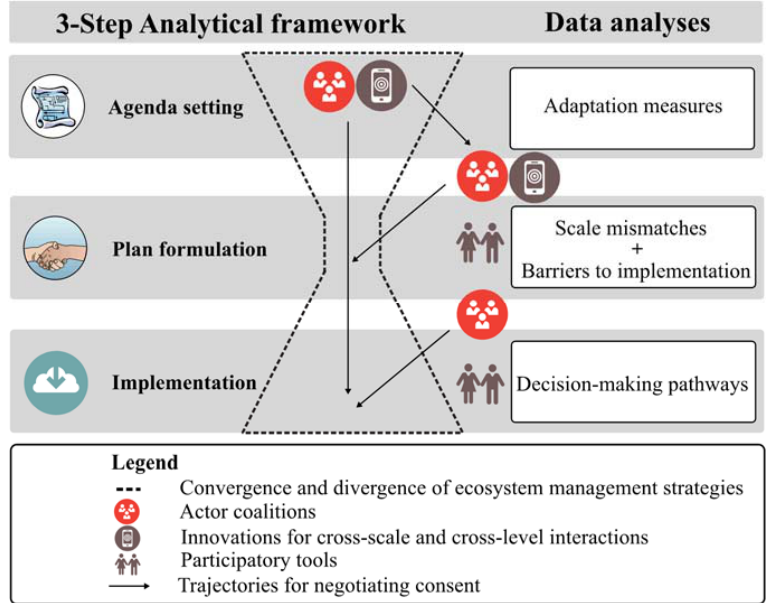
Figure 2. A stylised framework for strategic decision ‐ making and ecosystem management across scales and levels (adapted from [30]). Step 1—agenda setting—determines the adaptation measures, i.e., the on ‐ ground actions that can protect or repair the ecosystem, based on previous research. Step